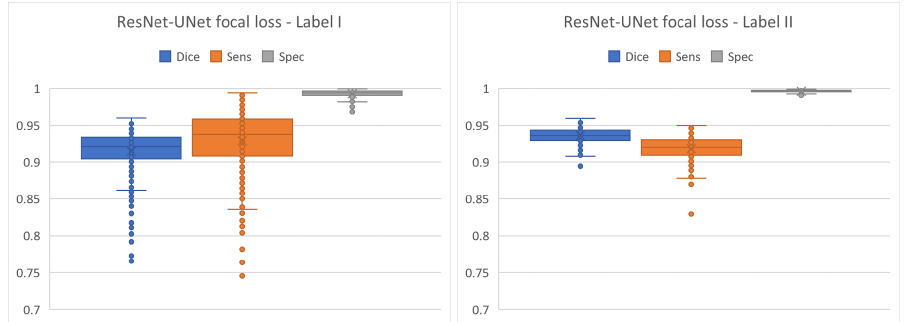
Figure 24. Improvement in labels in the two phases on the test set for focal loss.